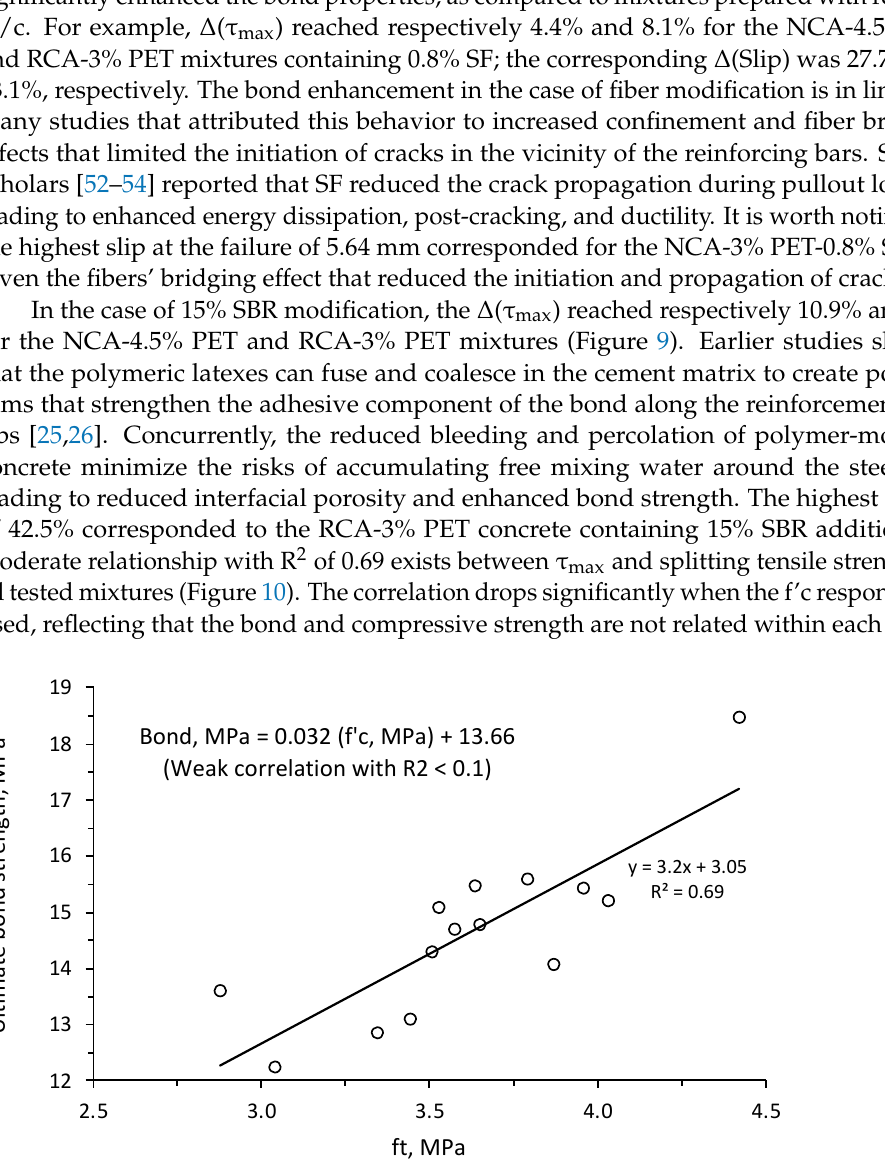
Figure 10. Relationship between bond strength and ft for all tested mixtures.